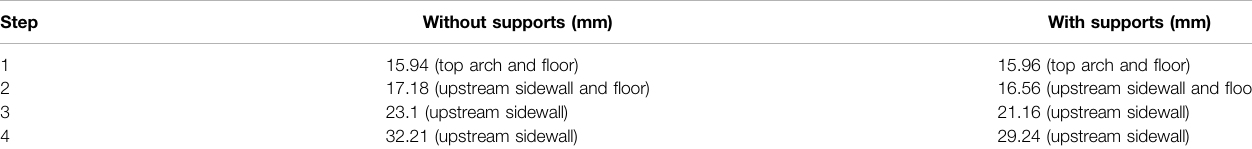
TABLE 5 | Summary of the maximum deformation under supported and nonsupported conditions.